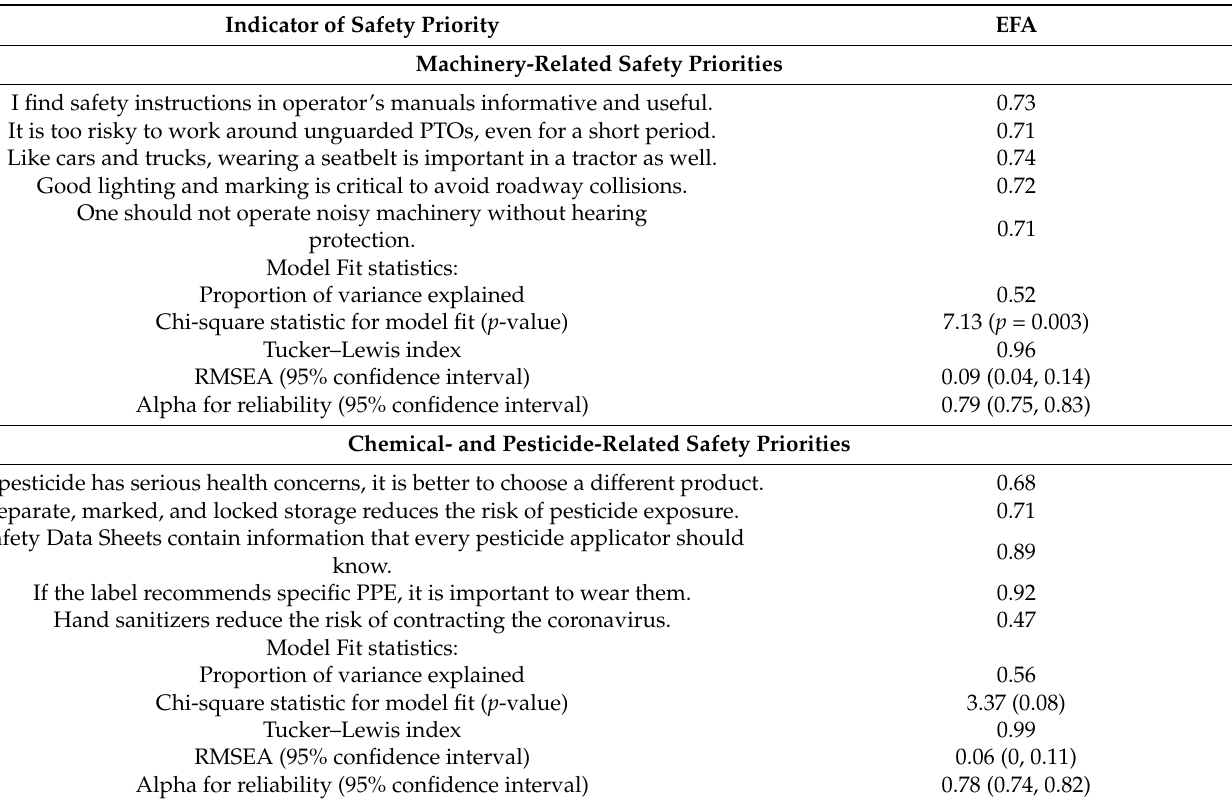
Table 5. Exploratory analysis for each of set of questions related to safety priorities in farm and ranch operators in the central states region of the US,